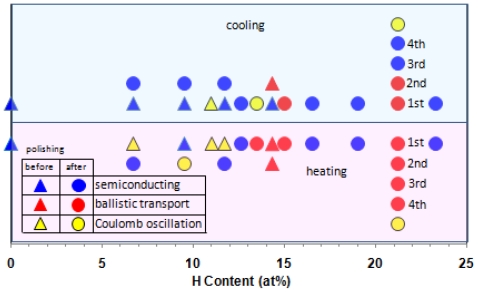
The effect of H content on the occurrence of semiconducting, ballistic transport and Coulomb oscillation properties of the (Ni0.39Nb0.25Zr0.35)100−xHx (0 ≤ x < 23.5) glassy alloys.